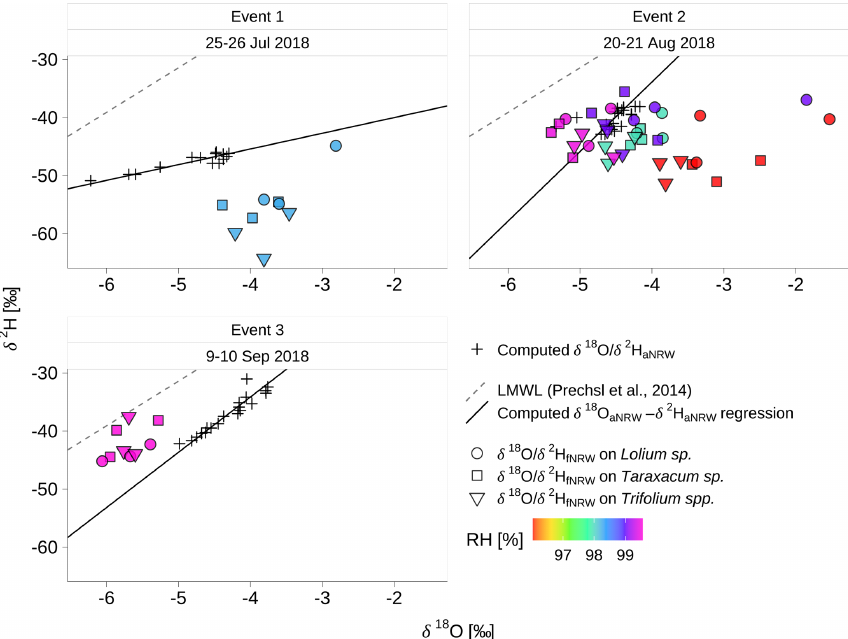
Figure 9. The relationship of δ 2 H fNRW − δ 18 O fNRW for non-rainfall water (NRW) on foliage with respect to the orthogonal regression of δ 2 H aNRW − δ 18 O aNRW for NRW equilibrium liquid from ambient water vapor and local meteorological water line (LMWL: δ 2 H = 7 . 68 × δ 18 O + 6.97; Prechsl et al., 2014). The filled colors of δ 18 O fNRW and δ 2 H fNRW represent the corresponding relative humidity at 2ma.g.l.